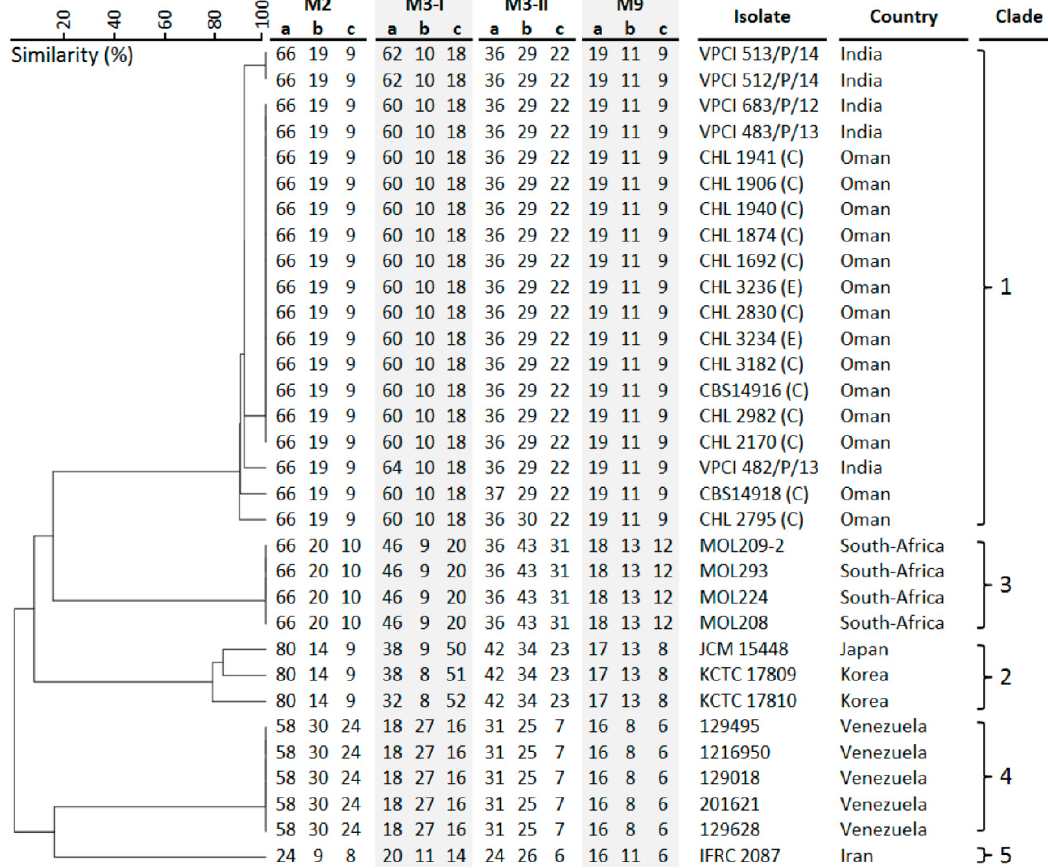
Table 2. MIC values of 12 Candida strains from the outbreak.